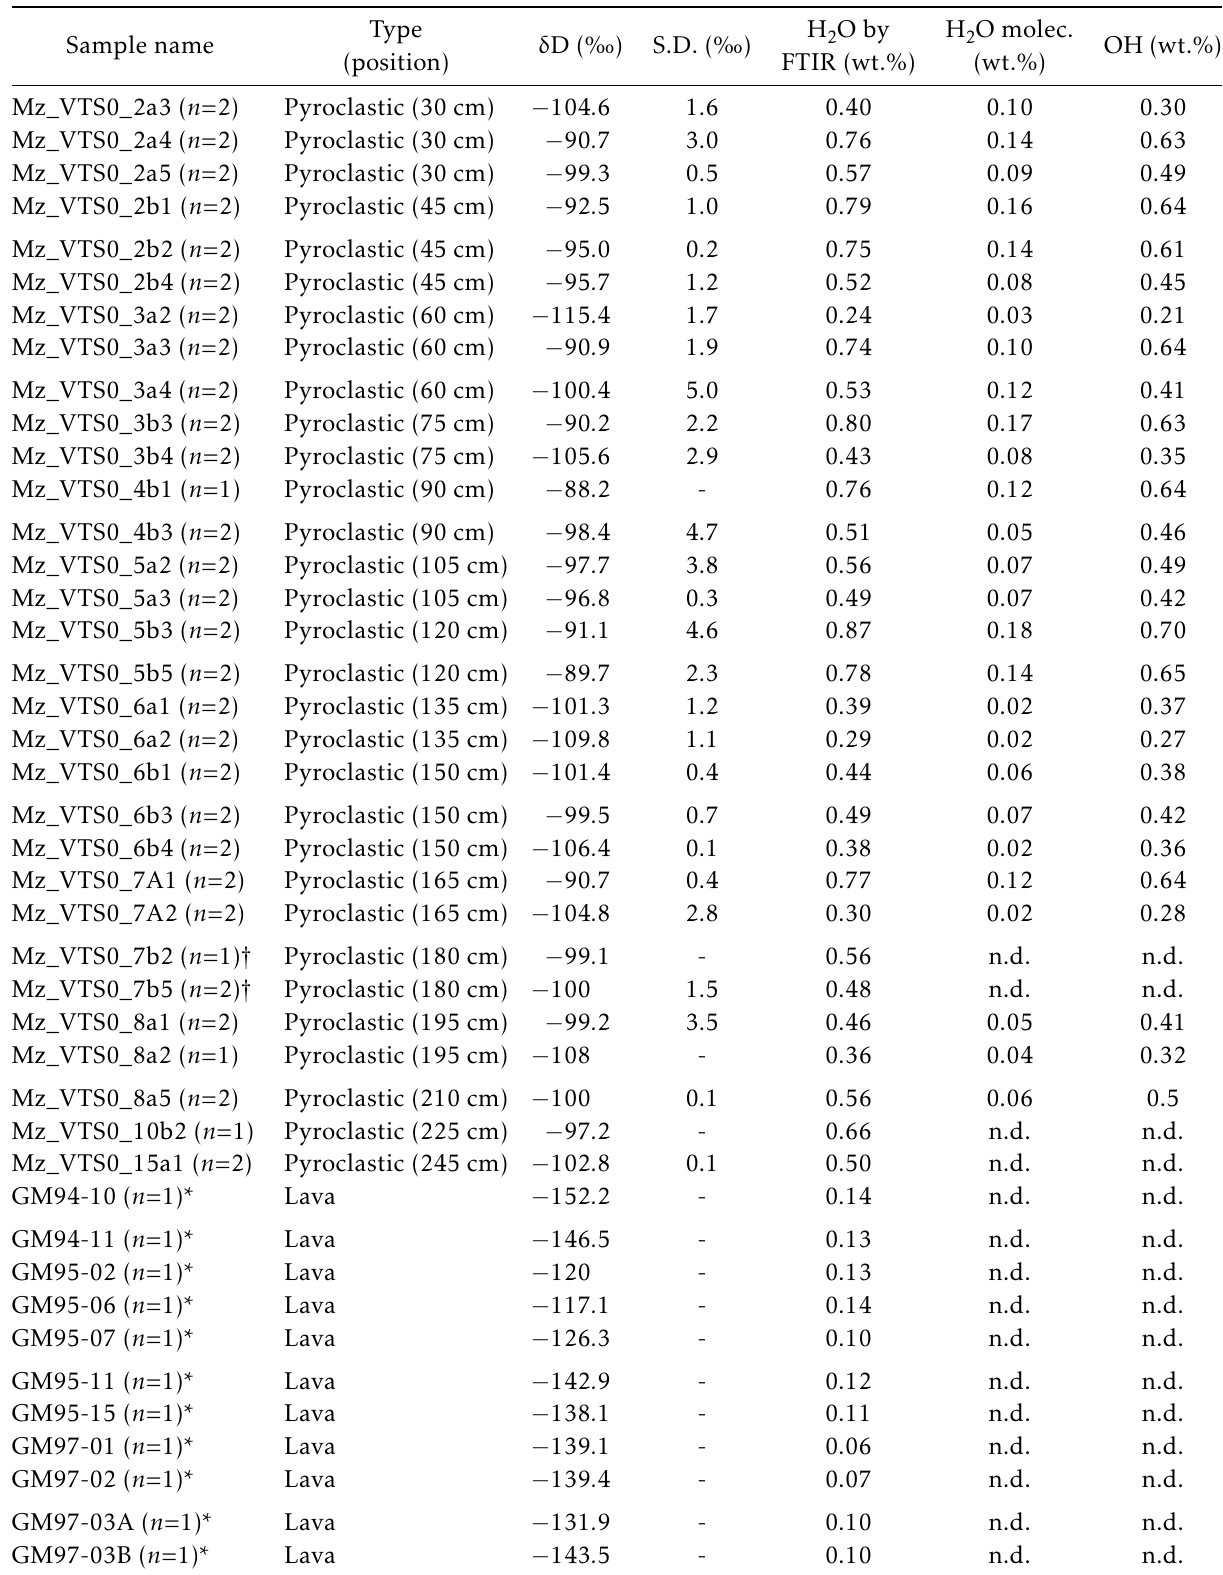
Table 1: δ D and bulk H 2 O content of pyroclastic and effusive obsidians from Big Glass Mountain, CA, USA. S.D. = standard deviation; n.d. = not